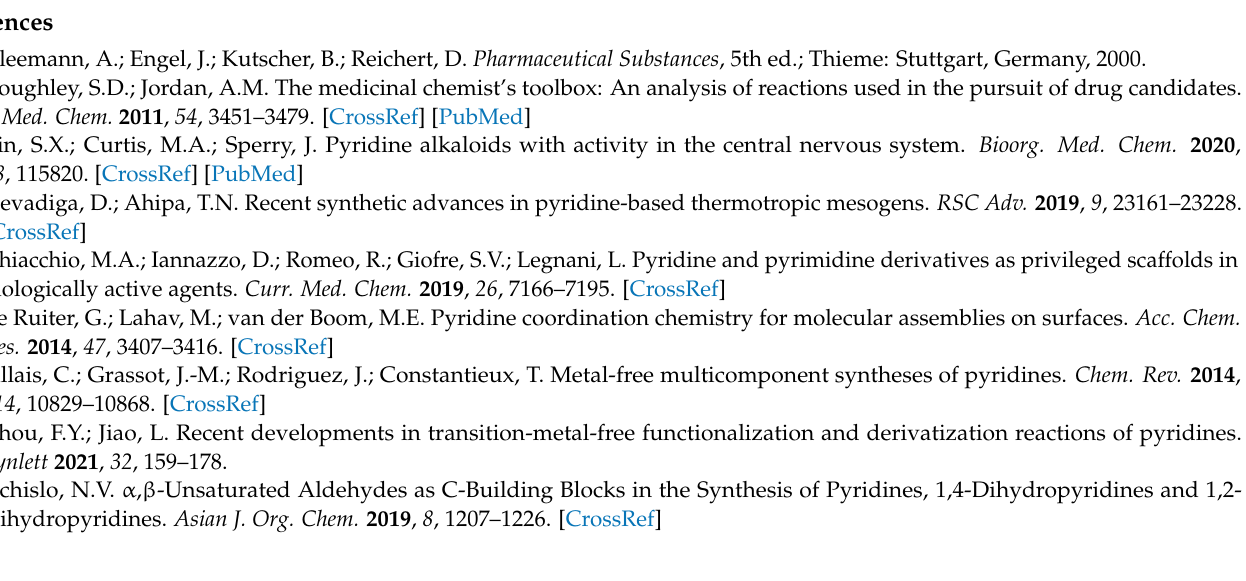
Figure S1: 1 H- and 13 C-NMR spectra of 3a ; Figure S2: 1 H- and 13 C-NMR spectra of 3b ; Figure S3: 1 H- and 13 C-NMR spectra of 3c ; Figure S4: 1 H- and 13 C-NMR spectra of 3d ; Figure S5: 1 H- and 13 C-NMR spectra of 3e ; Figure S6: 1 H- and 13 C-NMR spectra of 3f ; Figure S7: 1 H- and 13 C-NMR spectra of 3g ; Figure S8: 1 H- and 13 C-NMR spectra of 3h ; Figure S9: 1 H- and 13 C-NMR spectra of 3i ; Figure S10: 1 H and 13 C NMR spectra of 3j ; Figure S11: 1 H and 13 C NMR spectra of 4 ; Figure S12: 1 H- and 13 C-NMR spectra of 5 ; Figure S13: 1 H- and 13 C-NMR spectra of 6a ; Figure S14: 1 H- and 13 C-NMR spectra of 6b ; Figure S15: 1 H- and 13 C-NMR spectra of 7a ; Figure S16: 1 H- and 13 C-NMR spectra of 7b ; Figure S17: 1 H- and 13 C-NMR spectra of 7c ; Figure S18: 1 H- and 13 C-NMR spectra of 9a ; Figure S19: 1 H- and 13 C-NMR spectra of 9b ; Figure S20: 1 H- and 13 C-NMR spectra of 9c ; Figure S21: 1 H- and 13 C-NMR spectra of 9d